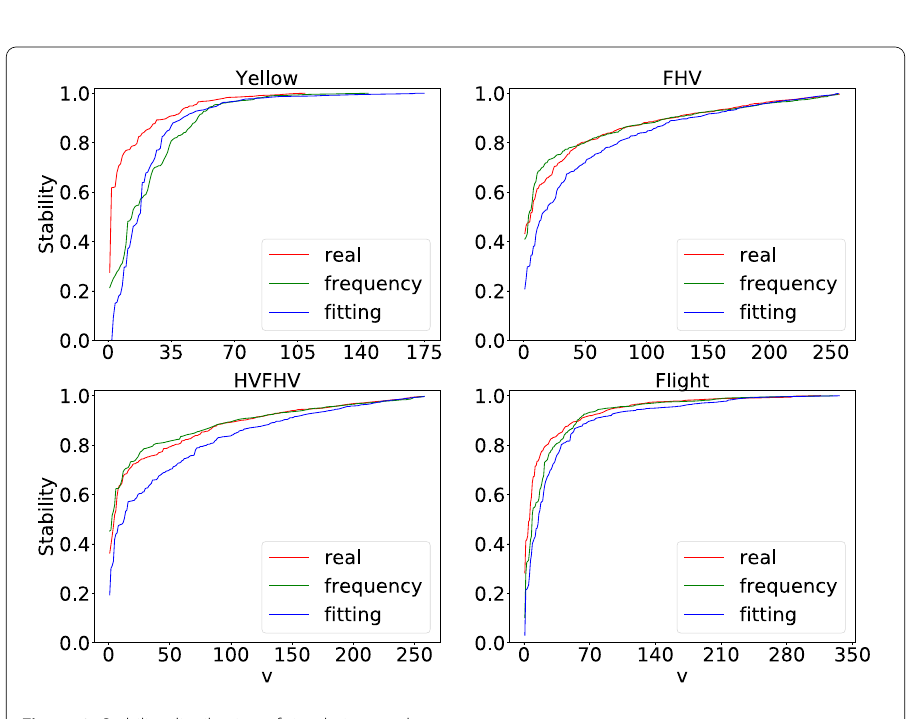
Figure 9 Stability distribution of simulation